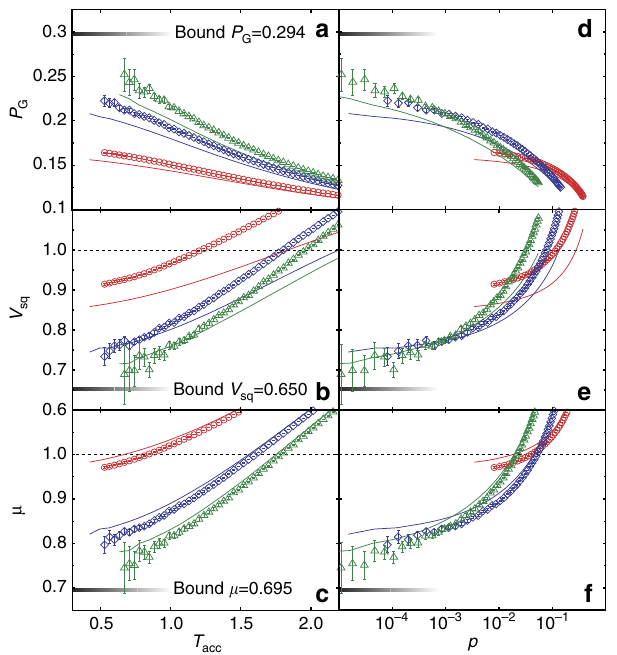
Figure 5 | Experimental distillation results. The panels a – f show the dependences of V sq , m and P G on the threshold T acc and success probability p for one (red, circle), two (blue, square) and three (green, triangle) iterations of the distillation protocol as discussed in the main text. The error bars give a 2 s confidence interval and are obtained by bootstrapping the samples 100 times where the length of each bootstrapping sample equals the length of the analysed data set. The solid lines give theoretical predictions obtained by Monte Carlo simulations for 10 10 samples. These simulations use the measured undiffused covariance matrix (equation 8) and the experimentally determined phase-noise factor q ¼ 0.78. The model takes into account additional losses induced by the implementation of our de-phasing channel, and, for simplicity, we assume an uncorrelated Gaussian distribution of the random phase shifts with equal variances. The general good agreement between simulation and experiment suggests that our model represents a good approximation. The discrepancy for V sq can be explained by the fact that the actual phase noise does not precisely meet our assumptions. By a slight change of q we could get a good fit for V sq at the expense of a worse fit for m . The short fading horizontal lines represent the asymptotic limit for projection onto vacuum ( (cid:2) n ¼